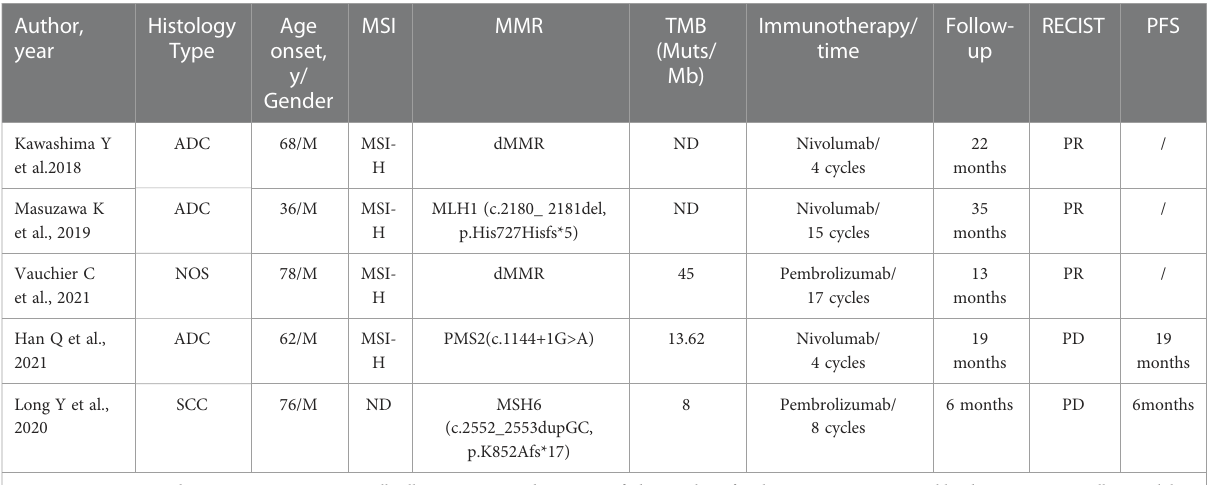
TABLE 2 Clinical information and ef fi cacy of ICIs in lung cancer patients with